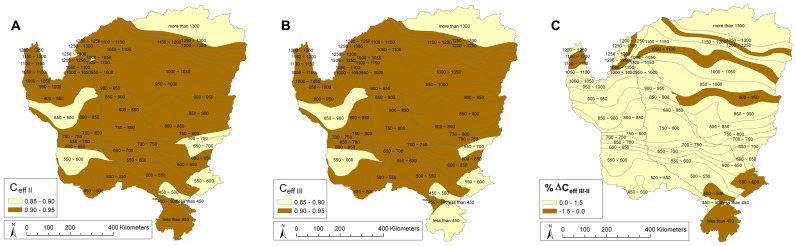
Spatial distribution of goodness-of-fit of the NDVI models.(A) final exploratory model II (FSPT) and (B) model III (FSPTE) with (C) highlighting the changes in goodness-of-fit between model III and II (% ΔCeff III - II = 100*[Ceff III - Ceff II]/Ceff III), average value = 0.40, max = 1.40 and min = −0.70. (Ceff: Nash-Sutcliffe Efficiency Coefficient).